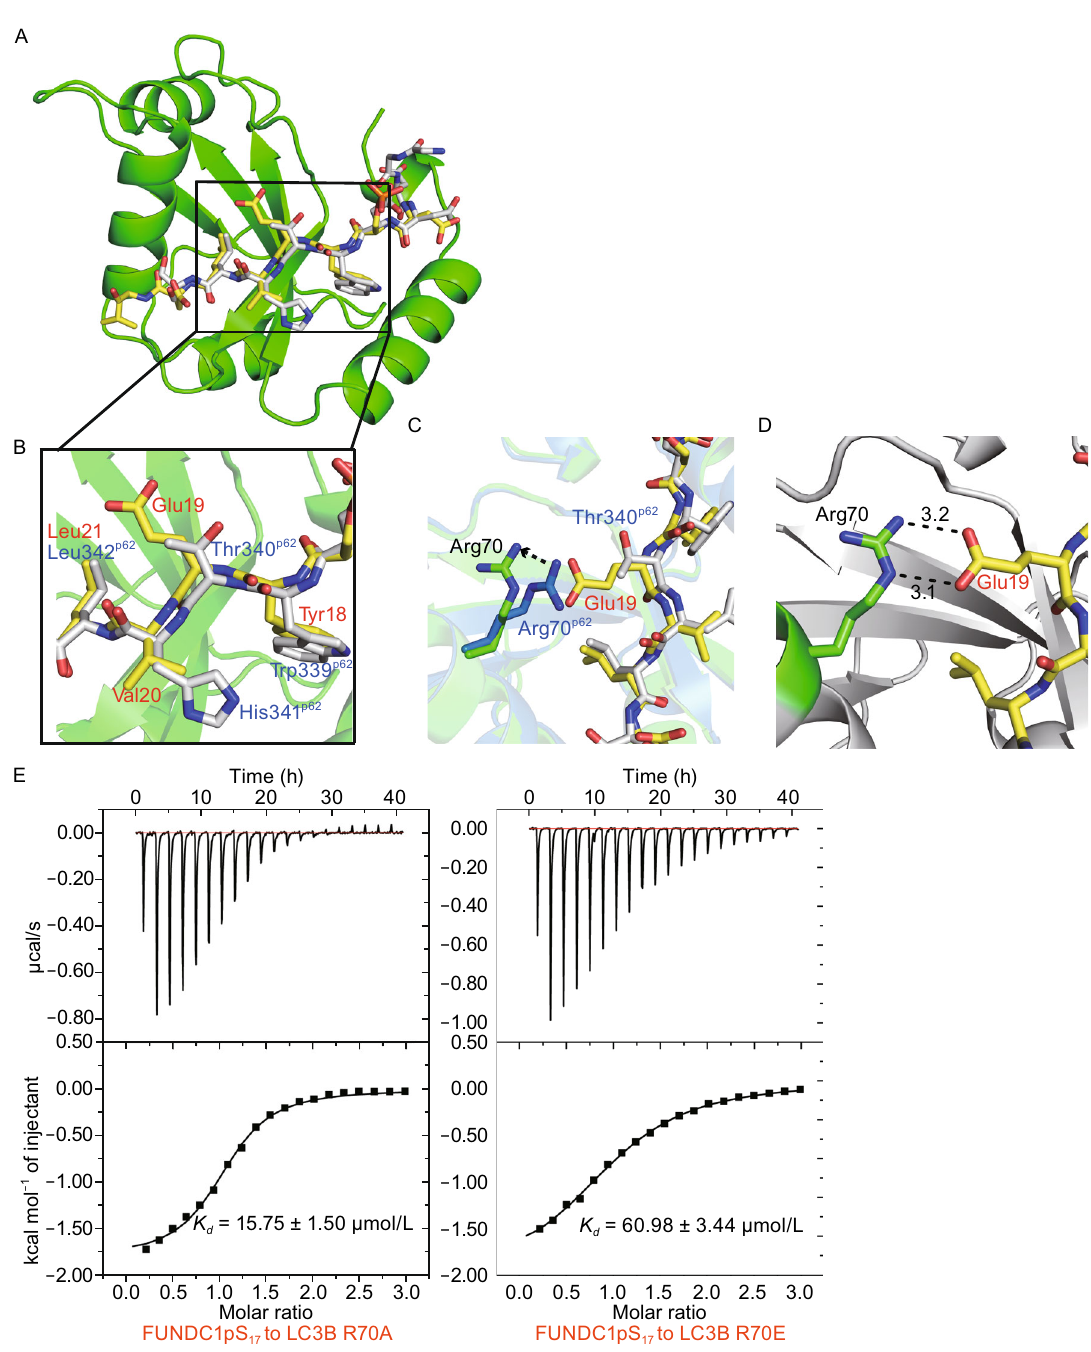
Fig. 4. Comparison of the LC3B-FUNDC1 complex and LC3B-p62 complex. (A) The superimposition of the LC3B-FUNDC1 complex on the LC3B-p62 complex. The superimposition only shows LC3B (green) in the LC3B-FUNDC1 complex (in two complexes, the two LC3B molecules only display a r.m.s. deviation for C α atoms of 0.489 Å). The FUNDC1 peptide is shown in yellow while the p62 peptide is colored white. (B) Close-up view of the structural comparison of LIRs in FUNDC1 (yellow) and p62 (white). Residues of LIRs in FUNDC1 and p62 are labeled in red and blue, respectively. (C) The difference of LC3B Arg70 (green and blue, respectively) recognized by FUNDC1 Glu19 (yellow) and p62 Thr340 (white). (D) Interactions between LC3B Arg70 and FUNDC1 Glu19. The surrounding structure of LC3B is represented in grey. Salt bonds are indicated as black dashes. (E) The ITC fi tting results of FUNDC1 pS 17 peptide with LC3B mutants at the Arg70